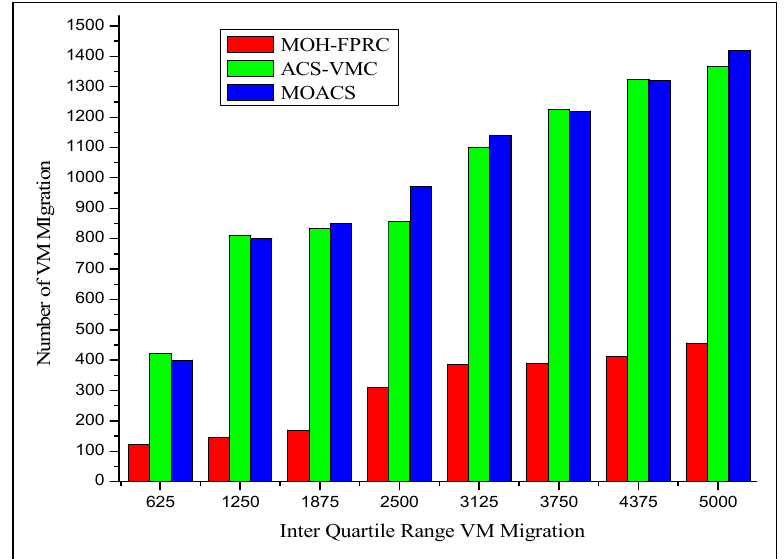
Figure 7. Comparison of number of VM migration using IQR.